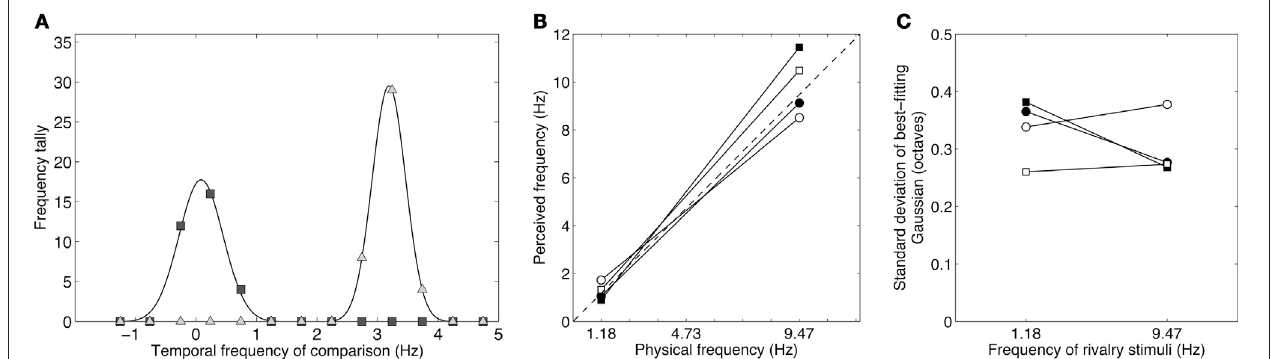
estimates of perceived frequency, it isclear that the perceived frequencies correlate very wellwith the actual frequencies. The group mean peak frequencies were1.25 and9.89Hz. (C) Thestandard deviations ofthe Gaussian distributions were similaracross the group. Allstandard deviations were well less than 0.5 (i.e., wellless than one-octave full-width at half height), indicating that subjects experienced clear rivalry alternations between the competing temporal frequencies and did not experience intermediate